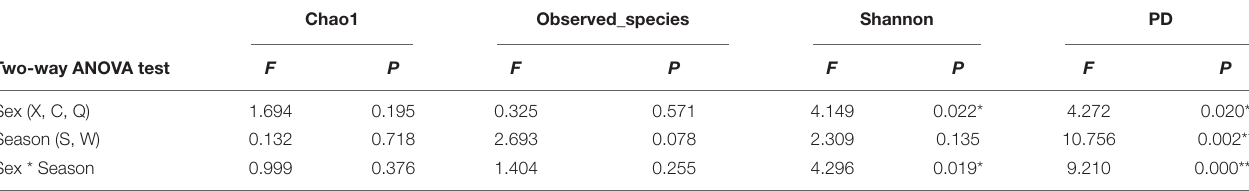
FIGURE 2 | UpSet plot analysis of the intestinal microbiota Nibea albiflora male, female, and all-female fish at the operational taxonomic unit (OTU) level. X, C, and Q represented male, female, and all-female fish, respectively. Two seasons: summer (S) and winter (W). (A) UpSet plot analysis at the operational taxonomic unit (OTU) level; (B) dominant composition of shared OTUs at class level; (C) histogram showed the relative abundance of class in six groups. TABLE 2 | Comparison of α -diversity metrics in groups and stages based on two-way ANOVA test. Chao1 Observed_species Shannon